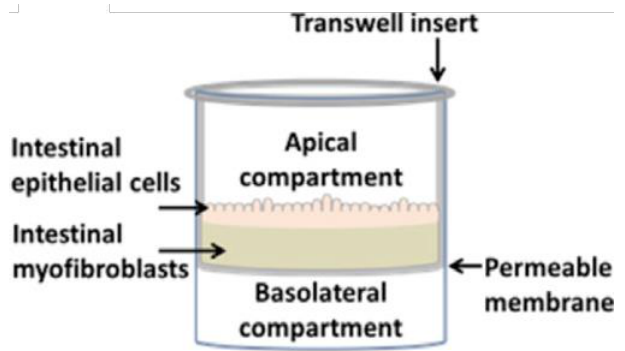
Figure 8. The 3D small intestinal microtissue engineered utilizing bioprinting of an interstitial layer containing adult human intestinal myofibroblasts followed by adult human intestinal epithelial cells creating a bilayered architecture. Adopted with permission from [3], Elsevier,